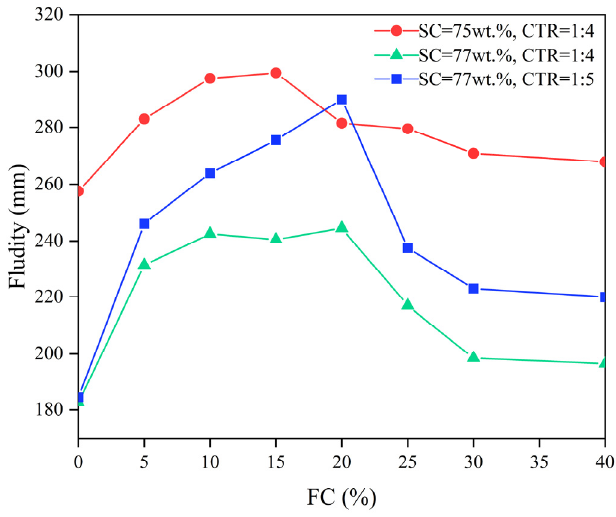
Figure 9. Relationship between the FC and the fluidity of FCPB.